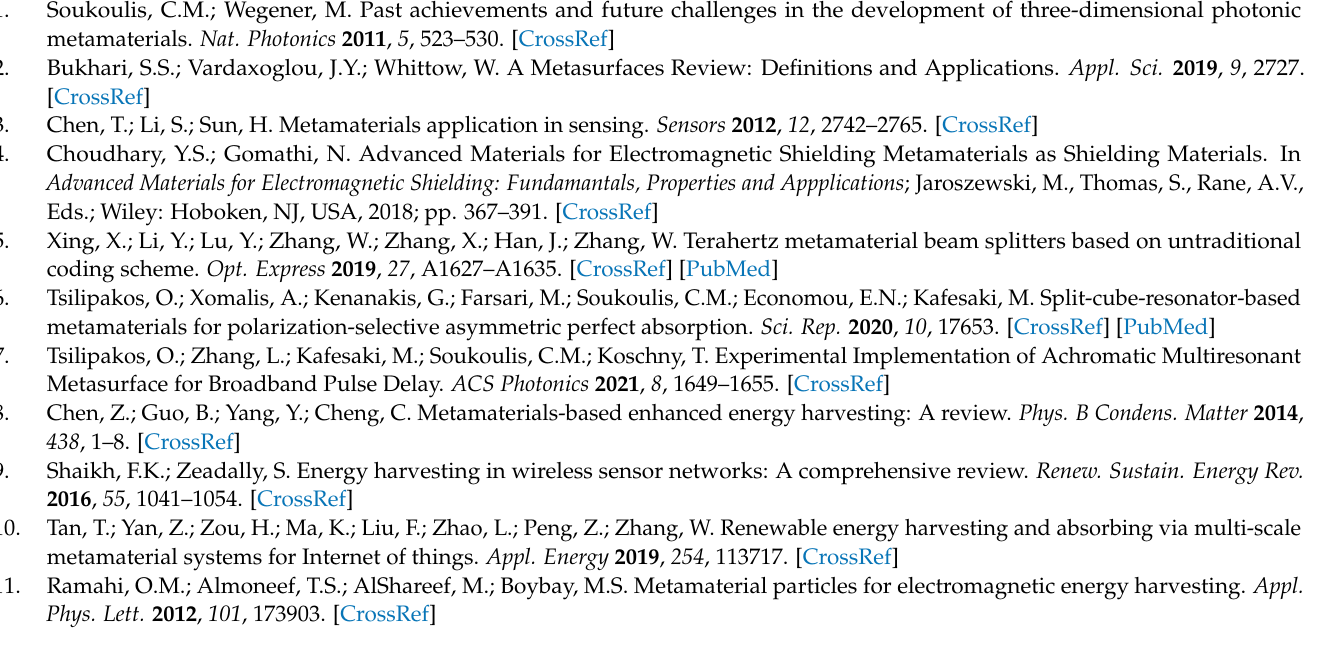
polarization angles, Figure S2: Simulations for the FR-4 built MS, with respect to polarization angles, Figure S3: Output voltage, with respect to polarization angles, for the Ag/PLA